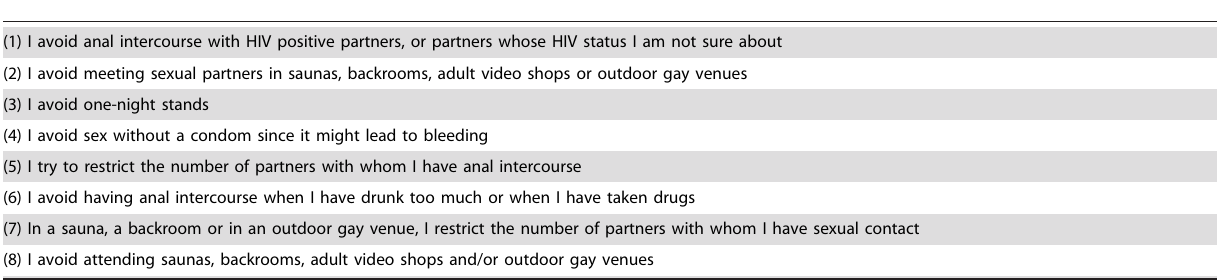
Table 1. Items used to compute the ‘‘intentional risk avoidance’’